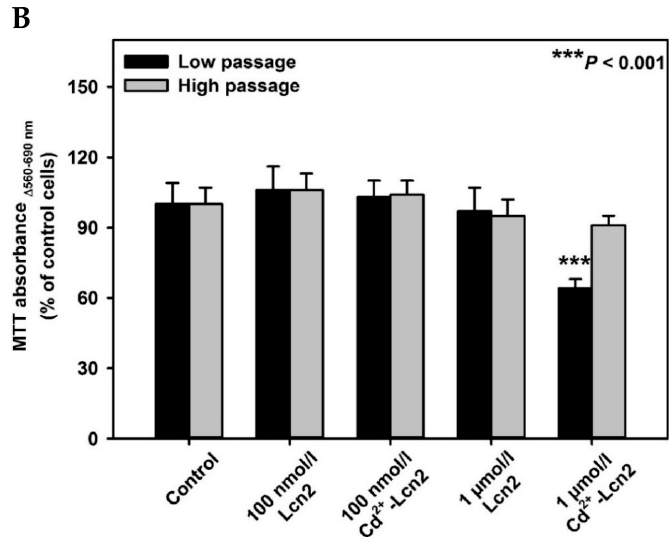
Figure 3. Relevant in vivo concentrations of Cd 2+ -complexes with β 2-microglobulin ( β 2M), albumin (Alb) or lipocalin-2 (Lcn2), but not metallothionein (MT), increase toxicity in megalin:cubilin-expressing WKPT-0293 Cl.2. Treatments were performed in SFM mod , and cell viability was assessed using MTT assay. ( A ) Low passage cells were exposed to glomerular filtrated proteins (ligands of megalin (MT, β 2M) or cubilin (Tf, Alb, α 1M)) alone or complexed to Cd 2 + for 24 h. Means ± SEM of 4–9 experiments are shown. Absorbance values of control cells were 1.06 ± 0.06 a.u. ( n = 31) and set to 100%. ( B ) Low and high passage cells were exposed to 100 nmol/L or 1 µmol/L of the megalin ligand Lcn2 or Cd 2+ -Lcn2 for 24 h. The higher concentration of 1 µmol/L approximates in vivo concentrations of Lcn2 in the glomerular ultrafiltrate (see Table 1). Means ± SEM of 4–6 experiments are shown. Absorbance values of control cells were 1.30 ± 0.12 a.u. ( n = 6) and 1.42 ± 0.25 a.u. ( n = 4) for low and high passage cells, respectively, and set to 100%. Statistical analyses for pairwise comparisons were performed using unpaired t -test. Table 1. Binding affinities and estimated concentrations of ligands of megalin and cubilin in the renal glomerular filtrate.